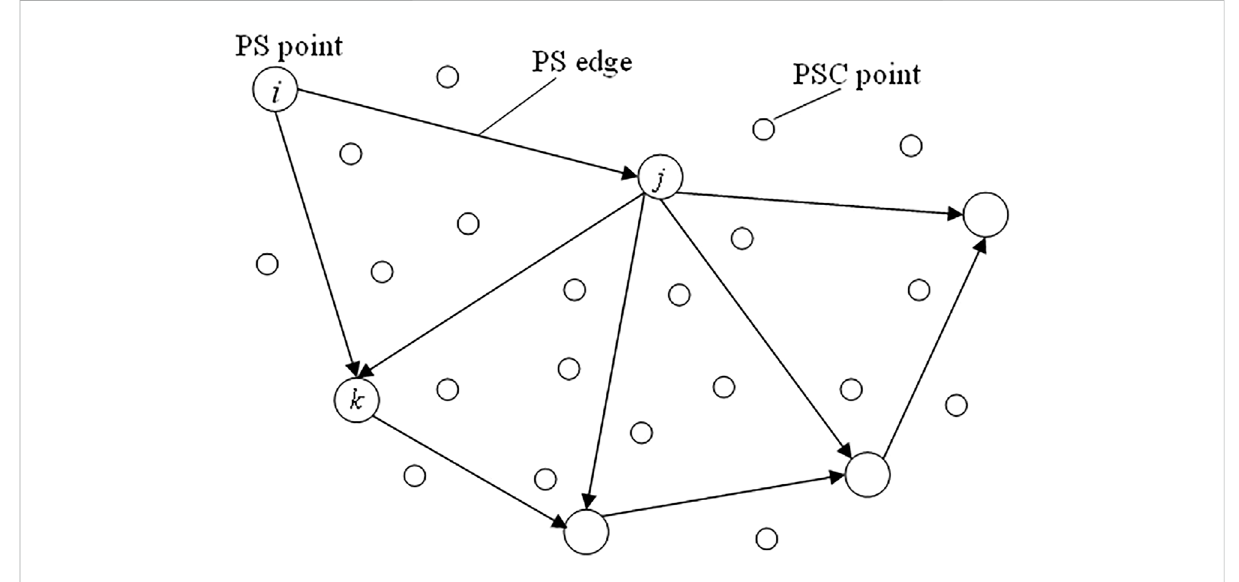
FIGURE 2 Schematic diagram of PS triangulation